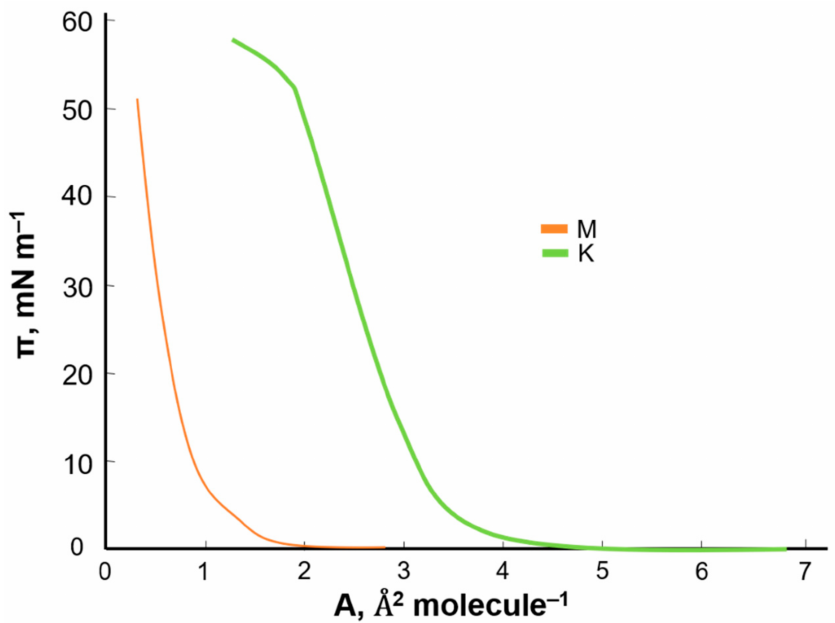
Figure 4. Surface pressure-area ( π –A) isotherms of myricetin (M) and kaempferol (K). Based on the obtained curves, it can be concluded that, with the simultaneous increase in the surface pressure, the surface area per single molecule decreased. The π –A isotherm shows the basic phase states: gas (G), extended liquid (LE), and condensed (LC) with the simultaneous occurrence of intermediate states (G/LE, LE/LC). At the maximum pressure value (collapsing pressure), the monolayer collapsed. The specific surface area of the PC was 59 Å 2 molecule − 1 . In the case of kaempferol and myricetin, intermediate states were not included in the graph. The two compounds tested had a much lower specific surface area than PC. The average area determined for a single molecule in a monolayer for kaempferol was 4 Å 2 molecule − 1 and for myricetin 1 Å 2 molecule − 1 . The registration of π –A isotherms with BAM’s simultaneous use enabled the visual- ization of phase transitions, providing more detailed information on the processes taking place [25,26]. BAM images obtained for kaempferol (Figure 5) and myricetin (Figure 6) are shown below.